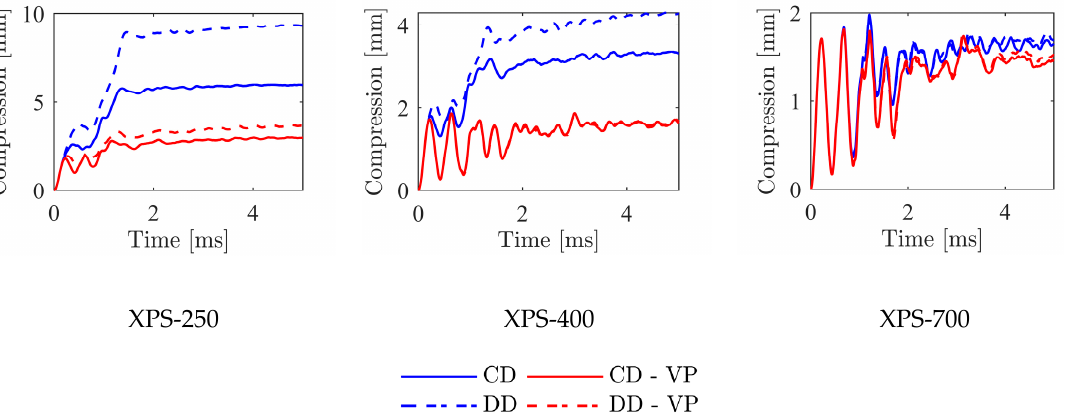
Figure 20. Core compression from simulations of tests at 10 bar driver pressure.